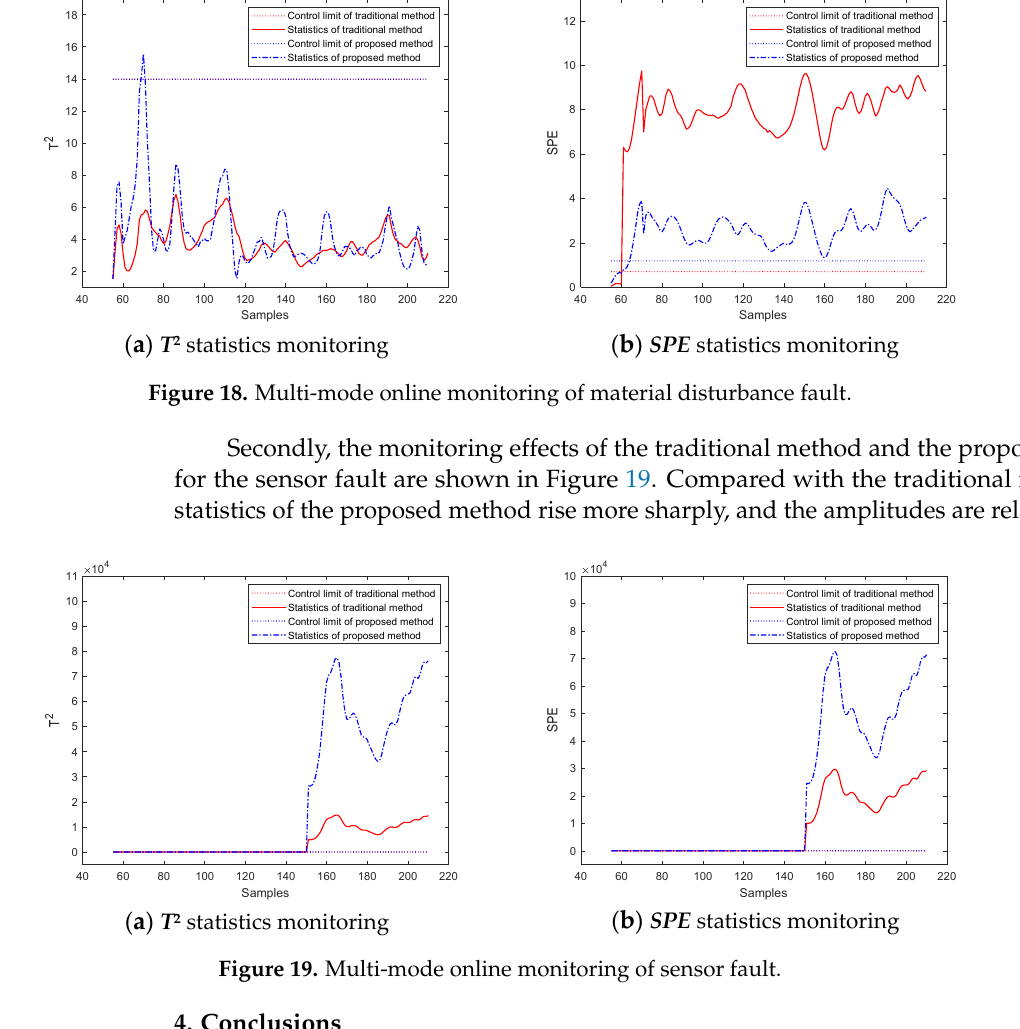
( b ) SPE statistics monitoring Figure 17. Multi-mode online monitoring of packing-holding phase of mode 1. In order to compare the prediction results of the single-mode model and the between- mode model of different prediction methods, RMSE values of five test batches in mode 3 and mode 1 are used for judgment, as shown in Table 4. According to the simulation results, it can be concluded that the between-mode model extracts the related information in the historical modes, so it contains more neces- sary information. It can be seen from Table 4 that the prediction results of the between- mode model are better than those of the single-mode model. Comparing the RMSE of the traditional method and the proposed method, it can be seen that the proposed method is more accurate for quality prediction. From the monitoring figures, it can be seen that if part of the mode information has been included in the modeling process, the statistics do not exceed the control limit, leading to a suitable monitoring effect. In contrast, if the mod- eling process does not contain the mode information, the statistics will exceed the control limits. To sum up, compared with single-mode modeling, the between-mode modeling contains more historical modal information, leading to better prediction, and can achieve the purpose of information selecting for monitoring. Therefore, for the current modes modeling, the between-mode modeling method can be selected.